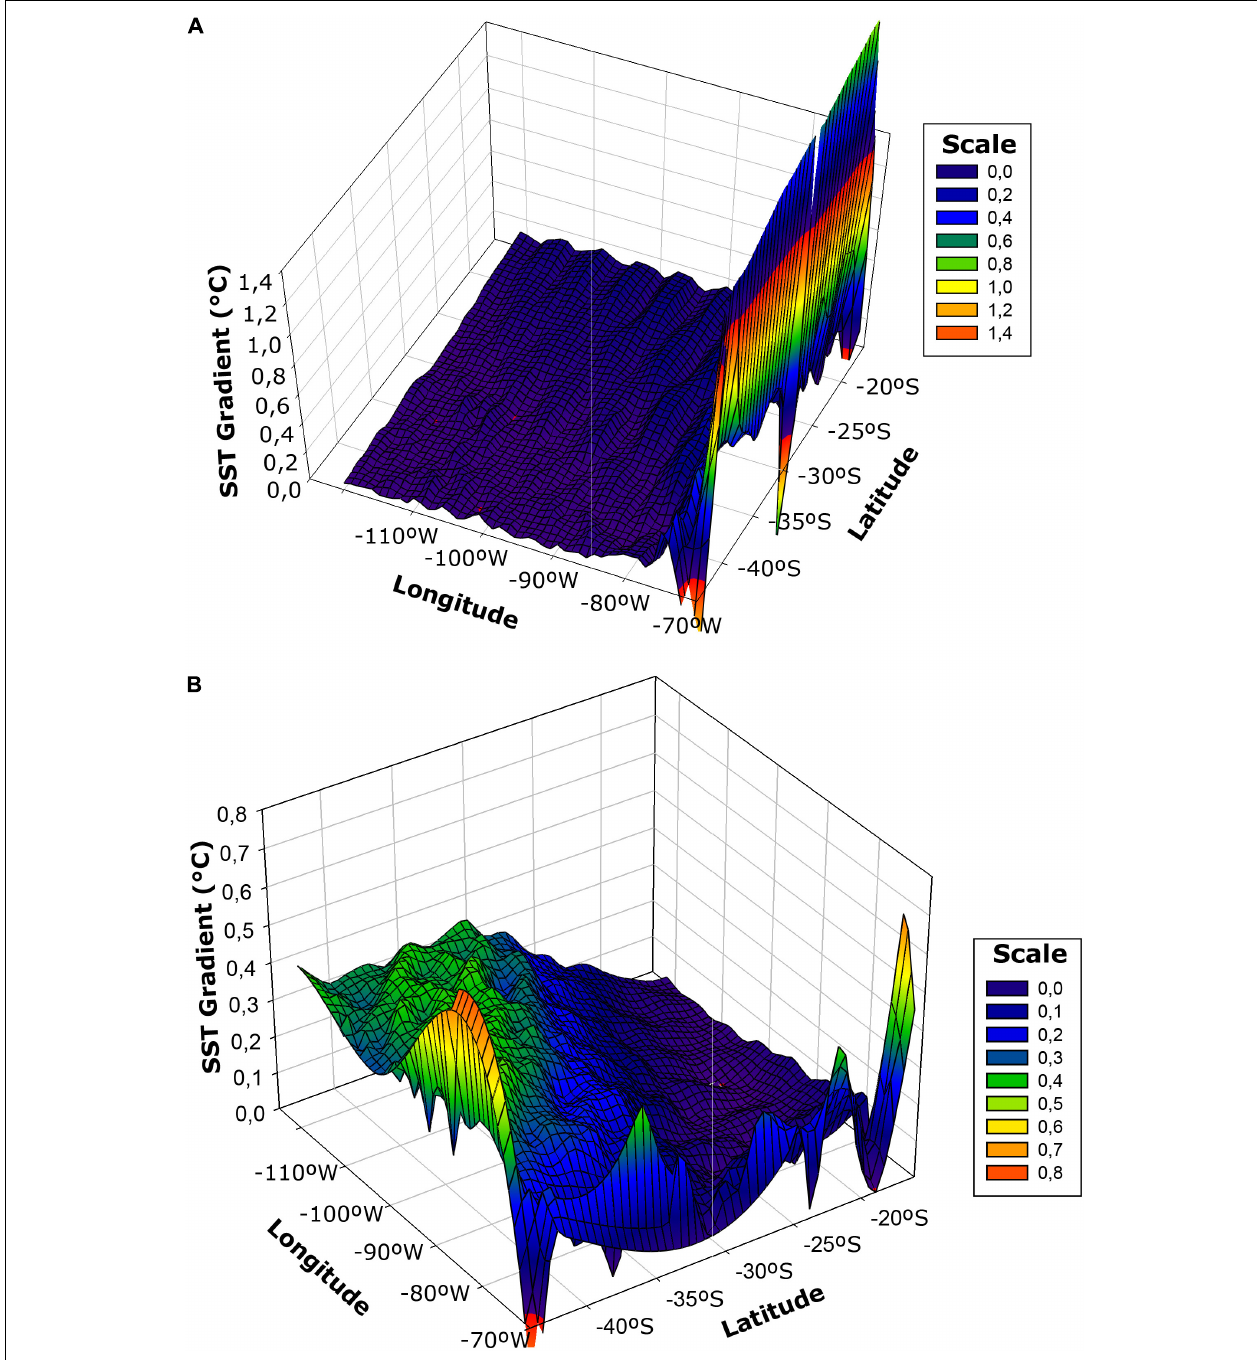
FIGURE 8 | Spatial gradients of sea surface temperature (SST) for the onshore-offshore (Zonal) (A) and the alongshore (meridional) (B) gradients in the southeast Pacific for the period 2002–2015. Gradient resolution is for 1 ◦ from mean monthly values of SST.